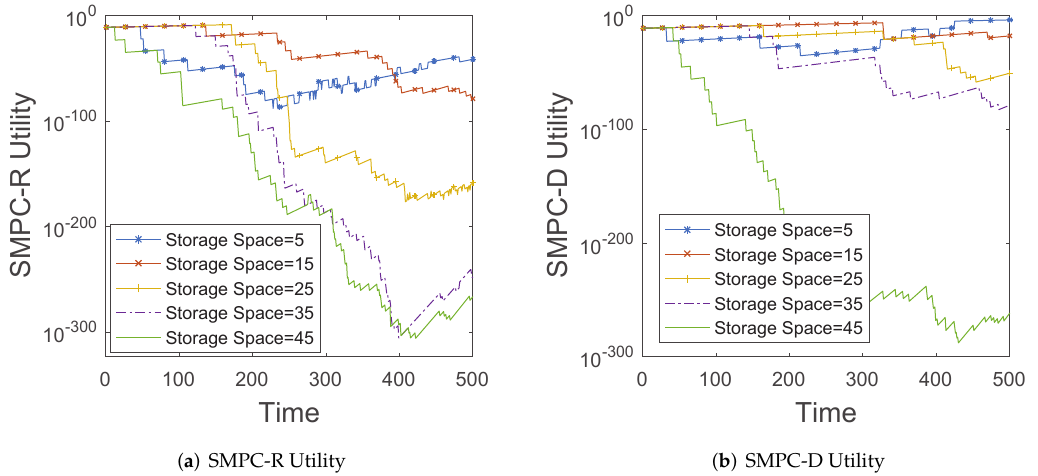
Figure 16. The changes of SMPC-R and SMPC-D utilities along with time t in the different storage